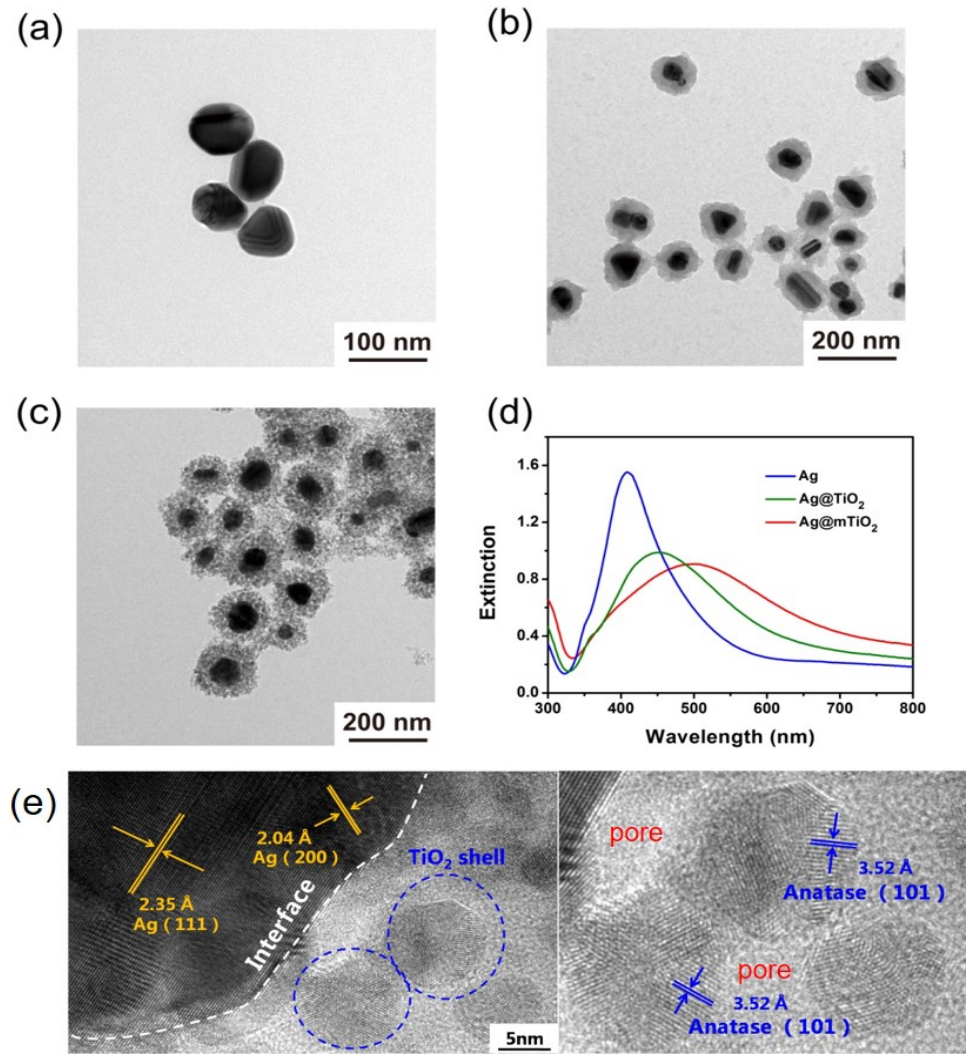
Figure 1. Typical TEM images of ( a ) Ag, ( b ) Ag@TiO 2 and ( c ) Ag@mTiO 2 nanoparticles. ( d ) UV-vis spectra of Ag (blue line), Ag@TiO 2 (green line) and Ag@mTiO 2 (red line). ( e ) The HRTEM image